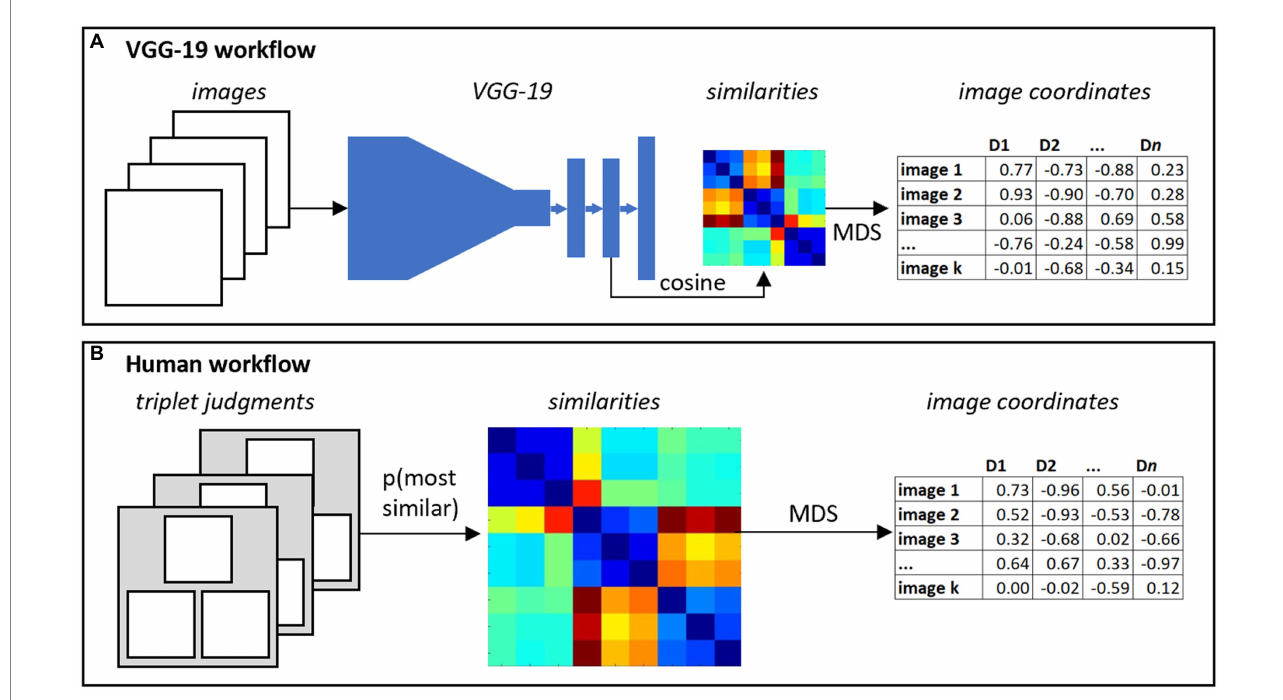
FIGURE 3 Two methods for capturing latent structure in sketches. (A) The VGG-19 workflow feeds each image into the neural network, extracts high-dimensional vectors from the penultimate layer, computes pairwise cosine similarities amongst all images, and reduces these to a small number of coordinates for each image using multidimensional scaling (MDS). (B) The human workflow collects most-similar judgments for a large set of triplets, computes pairwise probabilities that two images are chosen as most similar, and again uses MDS to reduce the similarity matrix to a small number of coordinates for each